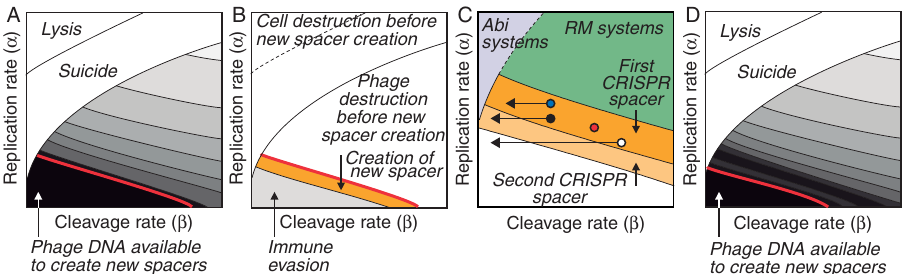
Fig.6|FunctionalconsequencesofCRISPR.A Contourplotofthepermanenceof phage DNA in the cytoplasm of infected bacteria according to Model 2. Different shades of gray indicate the time needed for nucleases to remove the phage DNA from the cytoplasm of an infected bacterial cell (lighter colors indicate a faster eliminationofphageDNA)HigherratesofDNAreplicationandcleavagereducethe time needed by nucleases to eliminate the phage DNA. The black region corre- spondsto slow phages that evade the action of nucleases.Wehypothesize thatthe timeittakesfornucleasestoremovephageDNAfromthecytoplasmofaninfected bacterialcellprovides amechanisticcriterionto include new phages intheCRISPR library. The late activation of the Cas enzymes (indicated by the red line) would constrainthecreationofnewspacersagainstsusceptiblephagesasshowninB.The phage DNA would only be available for these enzymes in the region that corre- sponds to slow phages. B Some susceptible phages would be eliminated from the cytoplasm of the host cell before the formation of Ca1-Cas2 complexes